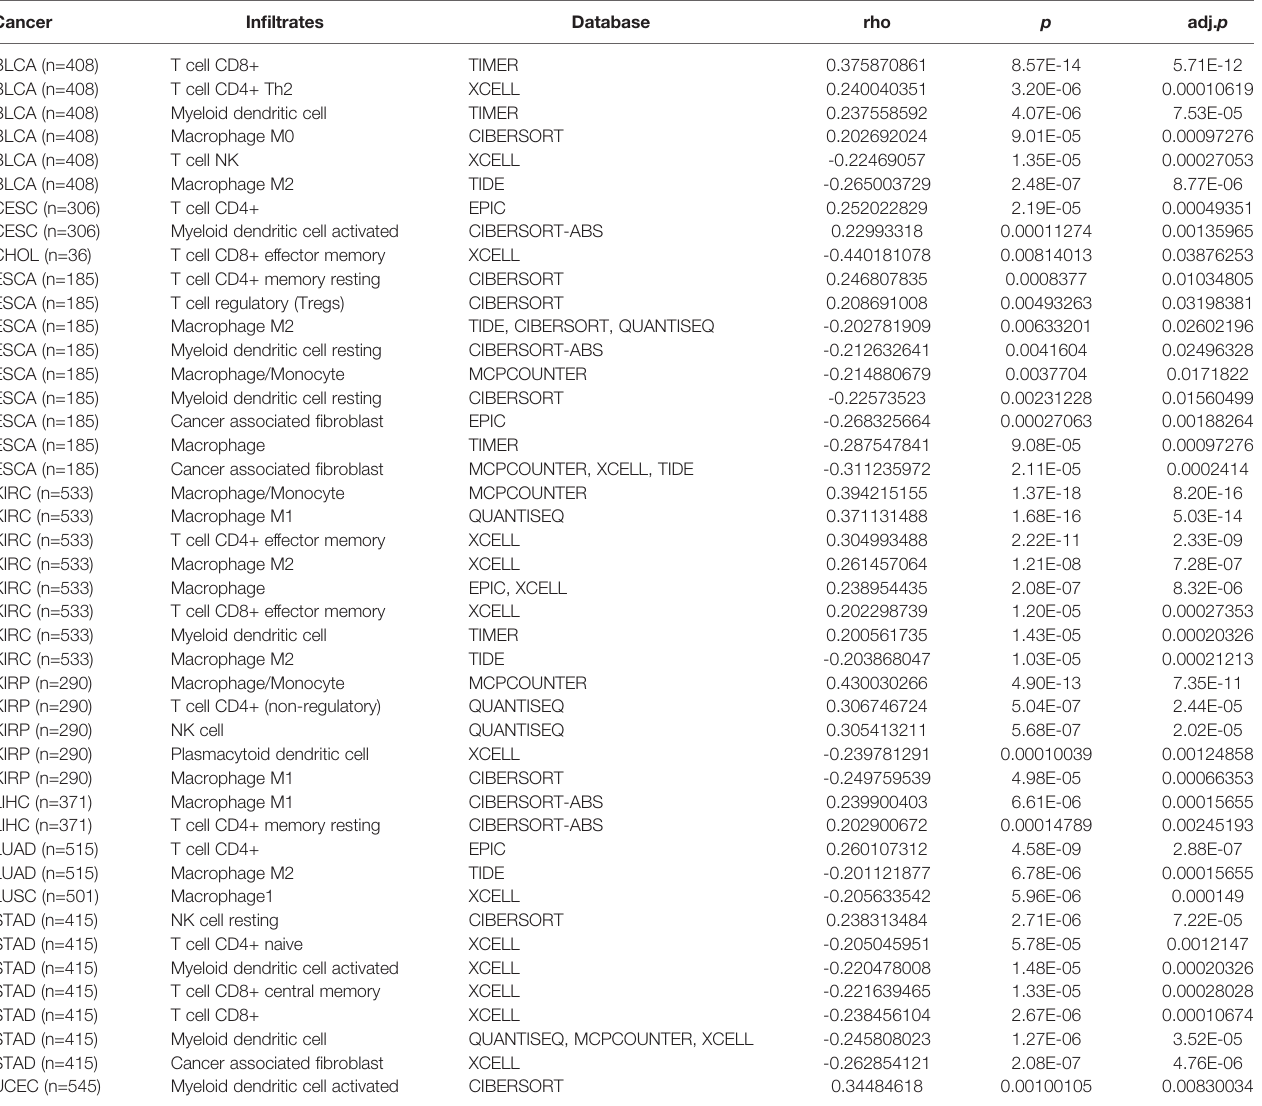
TABLE 1 | Correlation between IL22RA1 and immune cells in cancers with signi fi cance.